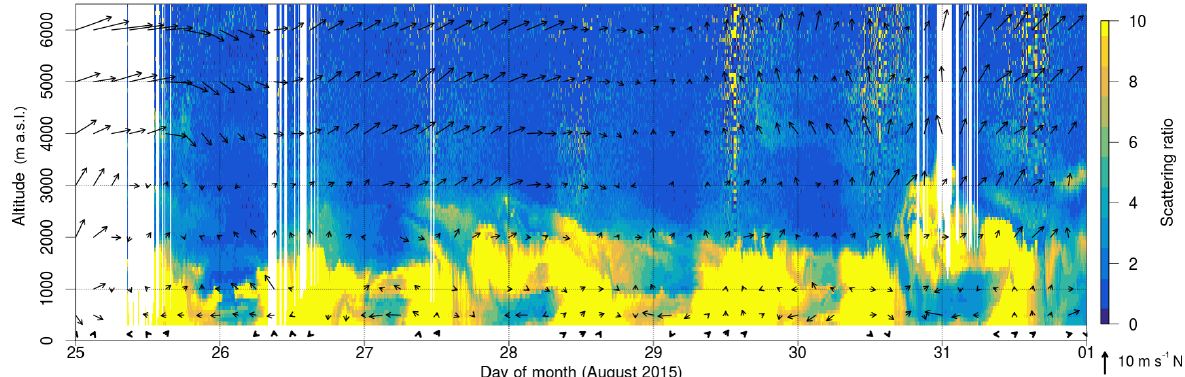
Figure 4. Vertical profile of scattering ratio from the ALC in Milan. Arrows: horizontal velocity of the wind measured at the surface (bold, lower arrows) and simulated by COSMO at several elevations (thin arrows).